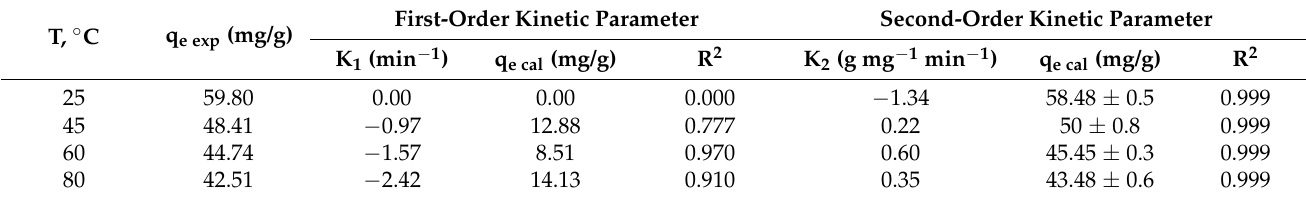
Table 4. The calculated parameters of the pseudo-first-order and pseudo-second-order kinetic model at different temperatures.